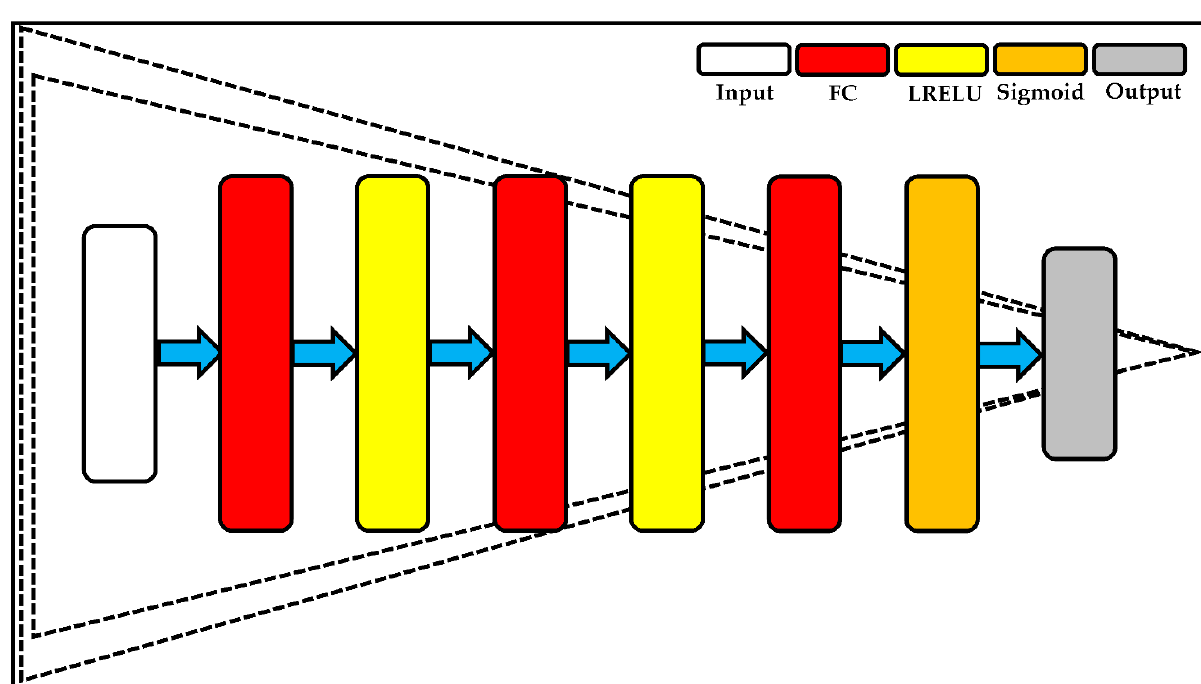
Figure 13. Composition of the decoder.